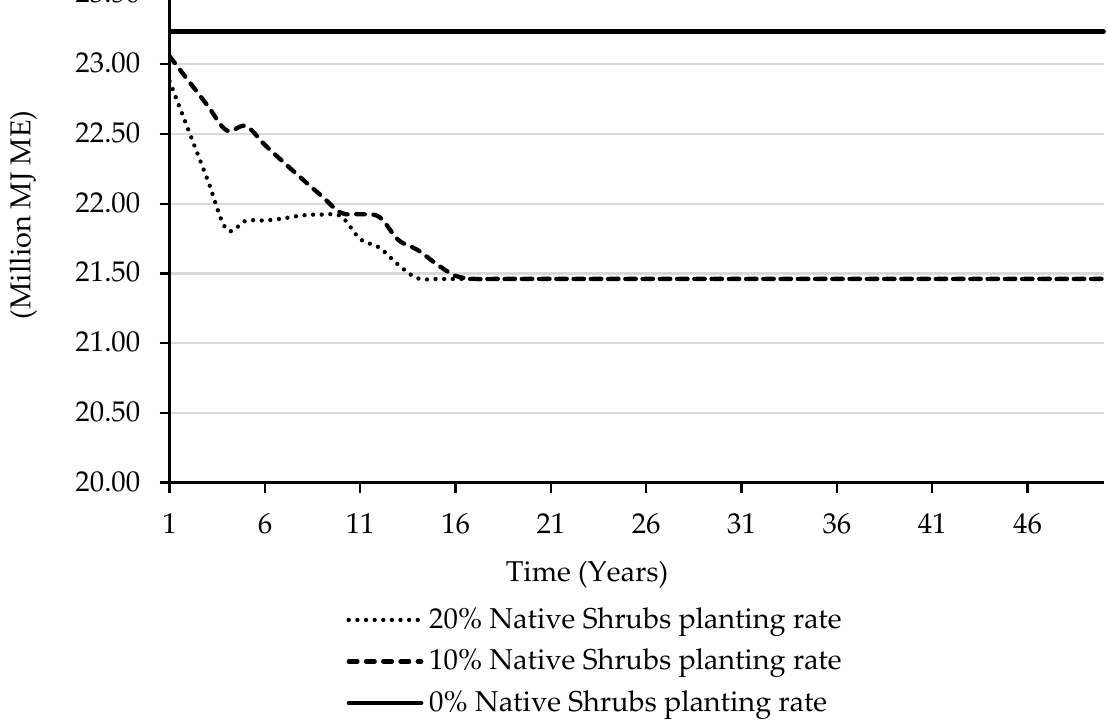
Table 4. Total mean farm annual feed supply in metabolizable energy (million megajoules) for the modelled farm based on low, medium, and steep slope types with shrubs planted on 10% of the farm at three planting rates (0%, 10%, and 20%) per year, and corresponding mean annual feed allocation to sheep and beef cattle.